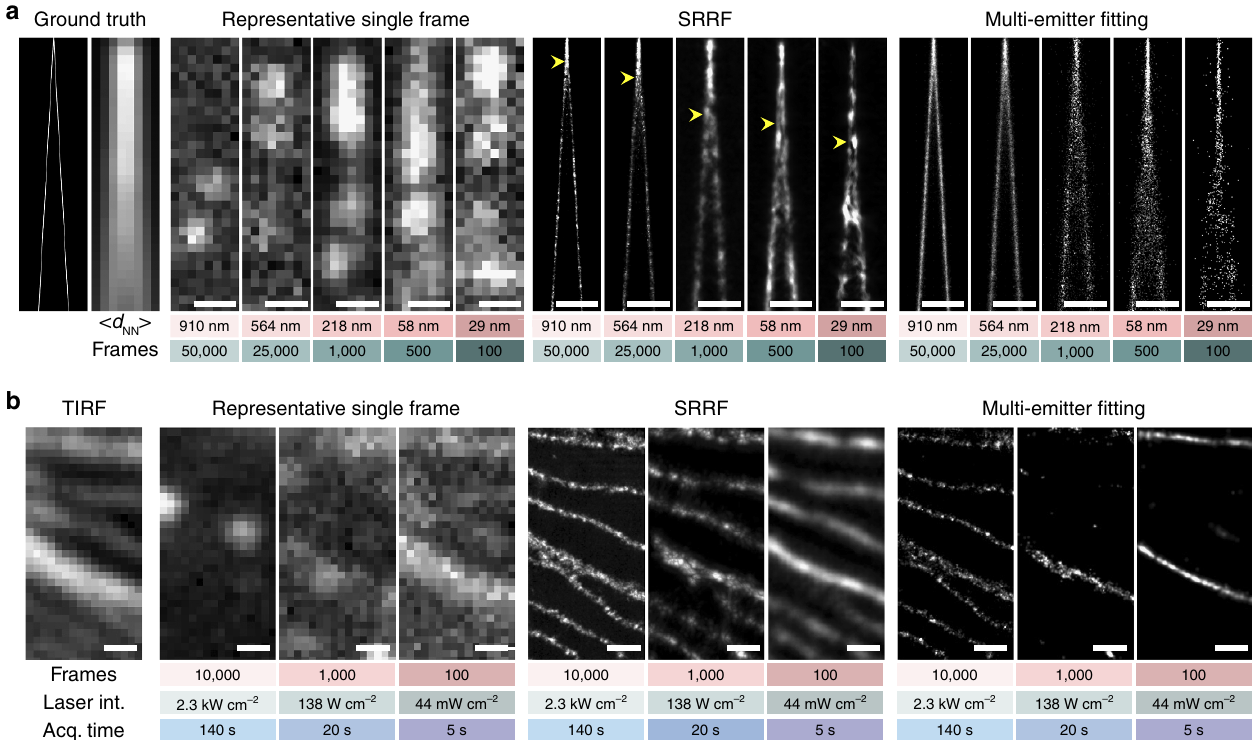
Figure 2 | SRRF applied from low- to ultra-high-fluorophore densities on simulated and experimental data. ( a ) Simulations of multiple densities of emitting fluorophores, mean nearest neighbour distance o d NN 4 , and number of frames shown underneath equivalent images. Ground truth consists of two diverging lines separated by 0nm (top) through to 350nm (bottom) with fluorophores placed every 5nm along the lines (further simulation parameters described in the ‘Methods’ section). Left: ground truth, equivalent diffraction limited image and representative single-simulated frames. Middle: reconstructions from SRRF. Right: reconstructions from multi-emitter fitting with maximum-likelihood estimation. Yellow arrows on SRRF reconstructions indicate point at which filaments are no longer resolved (from left to right 30, 50, 100, 110 and 140nm). Scale bars, 500nm. ( b ) Fixed microtubules labelled with Alexa Fluor 647, imaged with different laser intensities to produce different length data sets of varying fluorophore densities. Number of frames in data set, on-sample laser intensity and total acquisition time shown underneath images. The same region of the sample was imaged under each set of conditions. Far left: TIRF image of region. Left: representative single frames from acquired data sets. Middle: reconstructions from SRRF. Right: reconstructions from multi-emitter fitting with maximum likelihood estimation. Scale bars,